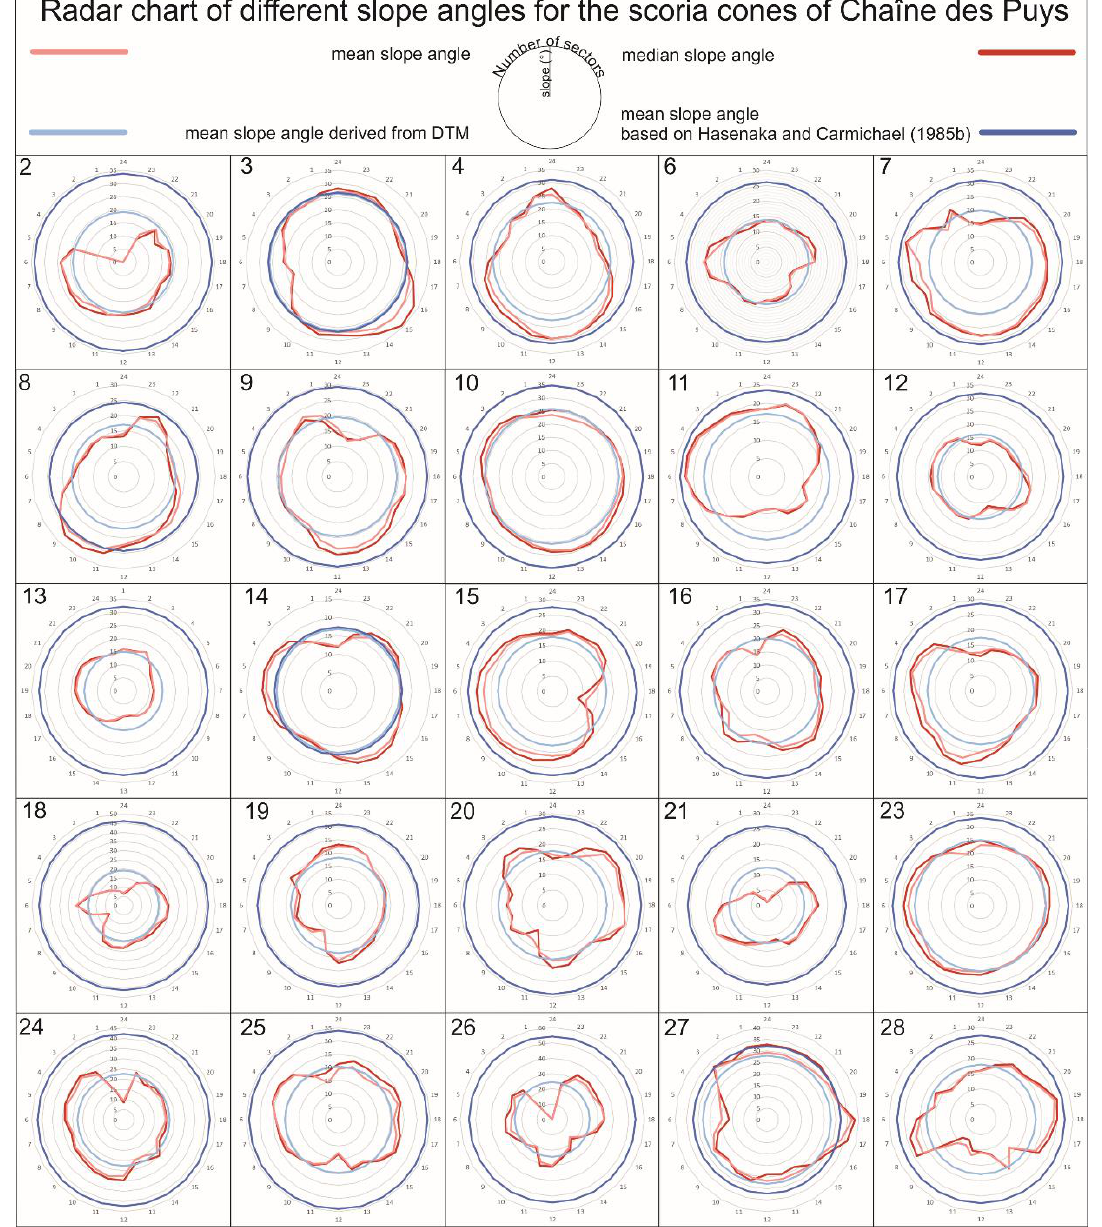
Figure 15. Sectorial values of mean slope angles (light red), of median of the slope angles (red). Blue circles are calculated values for the entire cone: light blue is the DTM-based mean slope, whereas the blue (outer) one is calculated according to the method of Hasenaka and Carmichael [35]. Note the great variety of the sectorial values.